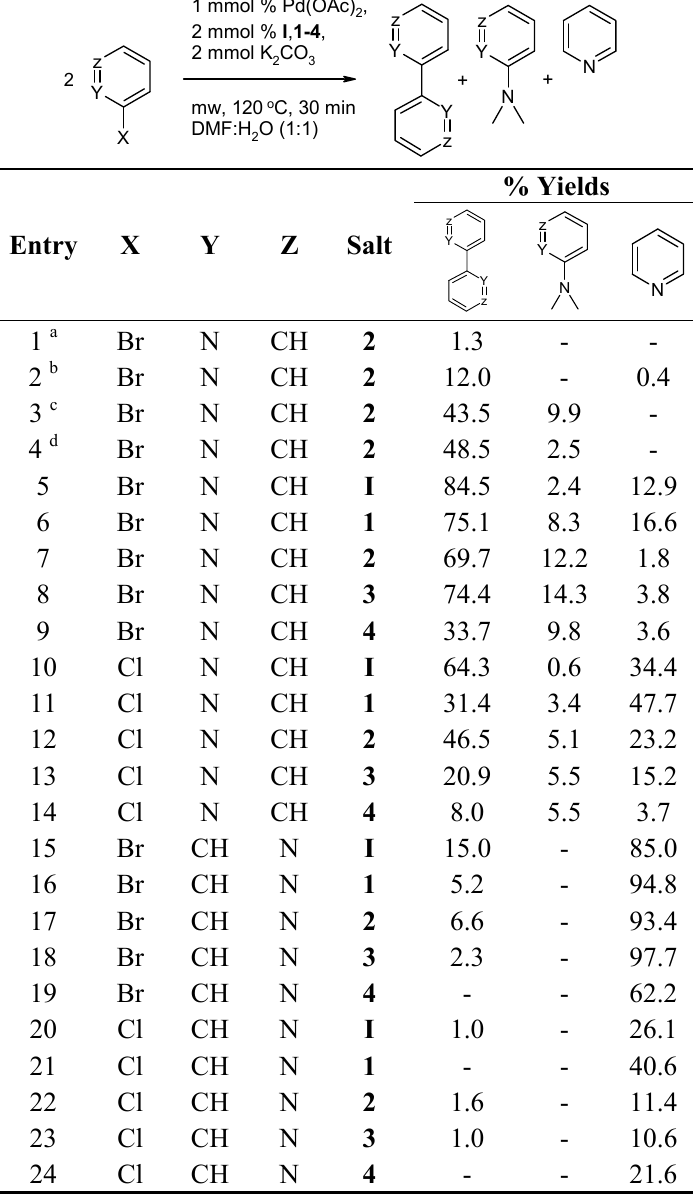
(Table 2, entry 3) and DMF/H O (1:1) (Table 2, entry 4) due to find the best one. Among the solvent 2 O (1:1) was found the good solvent systems but the homocoupling yield was still systems, DMF/H 2 low. Hence, the reaction time was increased to 30 min. Running the reaction for 30 min at DMF/H (1:1) mixture as a solvent we obtained reasonable homocoupling yield (Table 2, entry 5) and these , 2 mmol % of benzimidazolium salts and 2 mmol K parameters; 1 mmol % Pd(OAc) 2 DMF/H O (1:1) at 120 °C/300 W microwave heating were chosen as an optimum reaction conditions. 2 All of the results obtained using the optimum parameters for the Ullmann type coupling reactions, along with some side products, were given in Table 2. Table 2. The Ullmann type homocoupling reactions of halopyridines and side products.